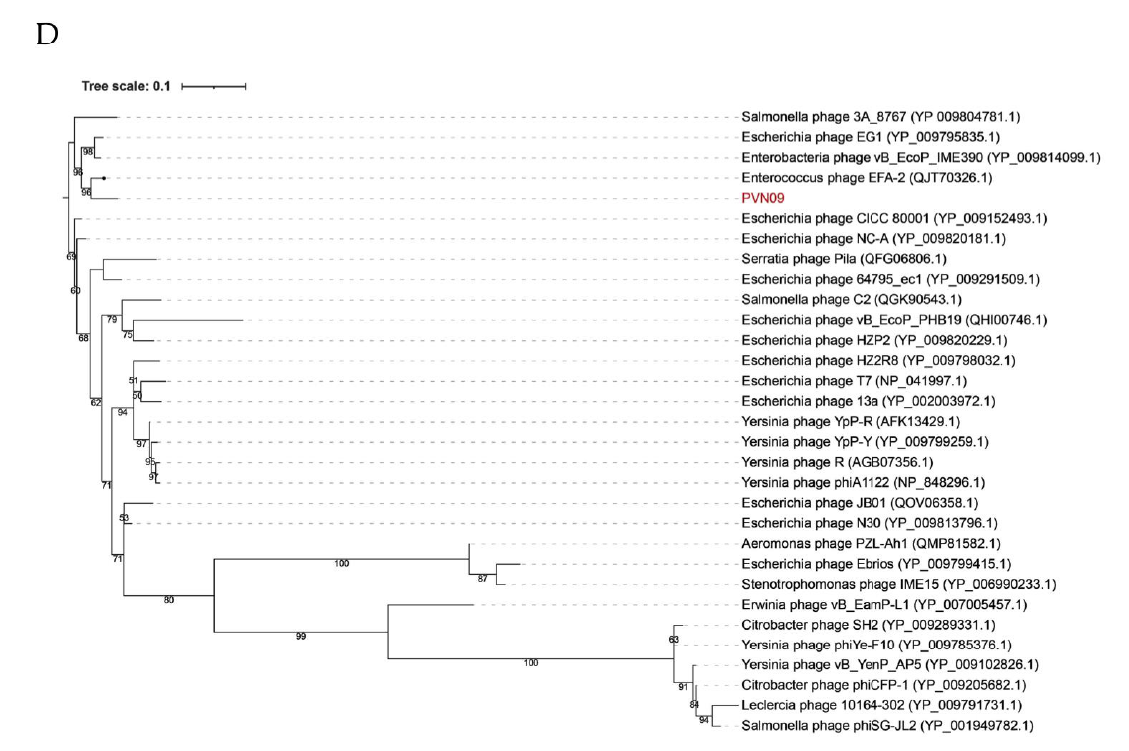
Figure 3. Genomic comparison of the E. ictaluri phage PVN06 and PVN09. ( A ) Schematic comparison of nucleotide sequences of phage PVN06 with sequences of Edwardsiella phage PEi21 (accession no. AP013057) and Edwardsiella phage MSW-3 (accession no. AB767244). ( B ) Genome comparison of phage PVN09 and selected representatives of phage T7 (accession no V01146), Enterobacteria phage vB_EcoP_IME390 (accession no. NC_048082), Salmonella phage 3A_8767 (accession no. MH382198), Escherichia phage CICC 80001 (accession no. NC_027387), Enterococcus phage EFA-2 (accession no. MT350293), using the Easyfig genome visualisation tool in BLASTn mode (version 2.2.3). Nucleotide similarity at different regions between genomes is given in percentages (right bar). The phage names are shortened and the functions of ORFs are marked with colors. Molecular phylogenetic analysis by the maximum likelihood method of BLASTp hits of large termirase sequences (TER) in phage PVN06 ( C ) or BLASTp hits of major capsid protein (MCP) in phage PVN09 ( D ). Sequences were aligned with MAFTT, and trees were constructed with IQ-TREE with 1000 bootstrap replicates. The percentage of trees in which the associated taxa clustered together is shown next to the branches (100 replicates). Each phylogenetic analysis was involved to 31 sequences.